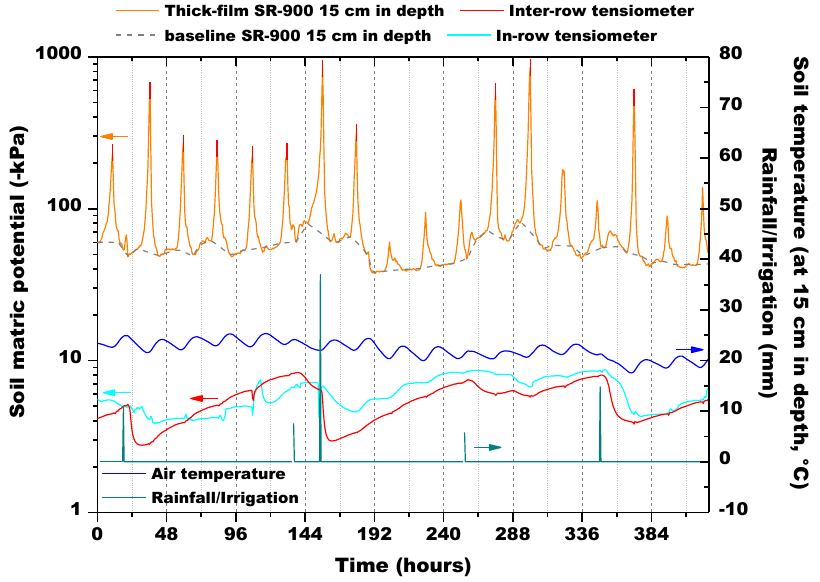
Figure 20. Field sensors response (origin of the curves is on August, 1st at